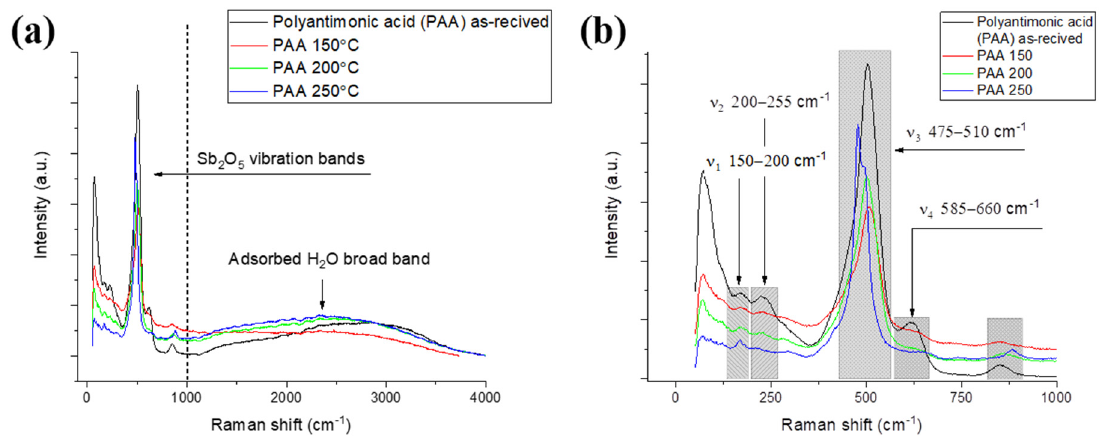
Figure 7. In situ X-ray patterns obtained for the 80PAA sample without the binder upon heating in the range 30–330 °C with steps of 10 °C.